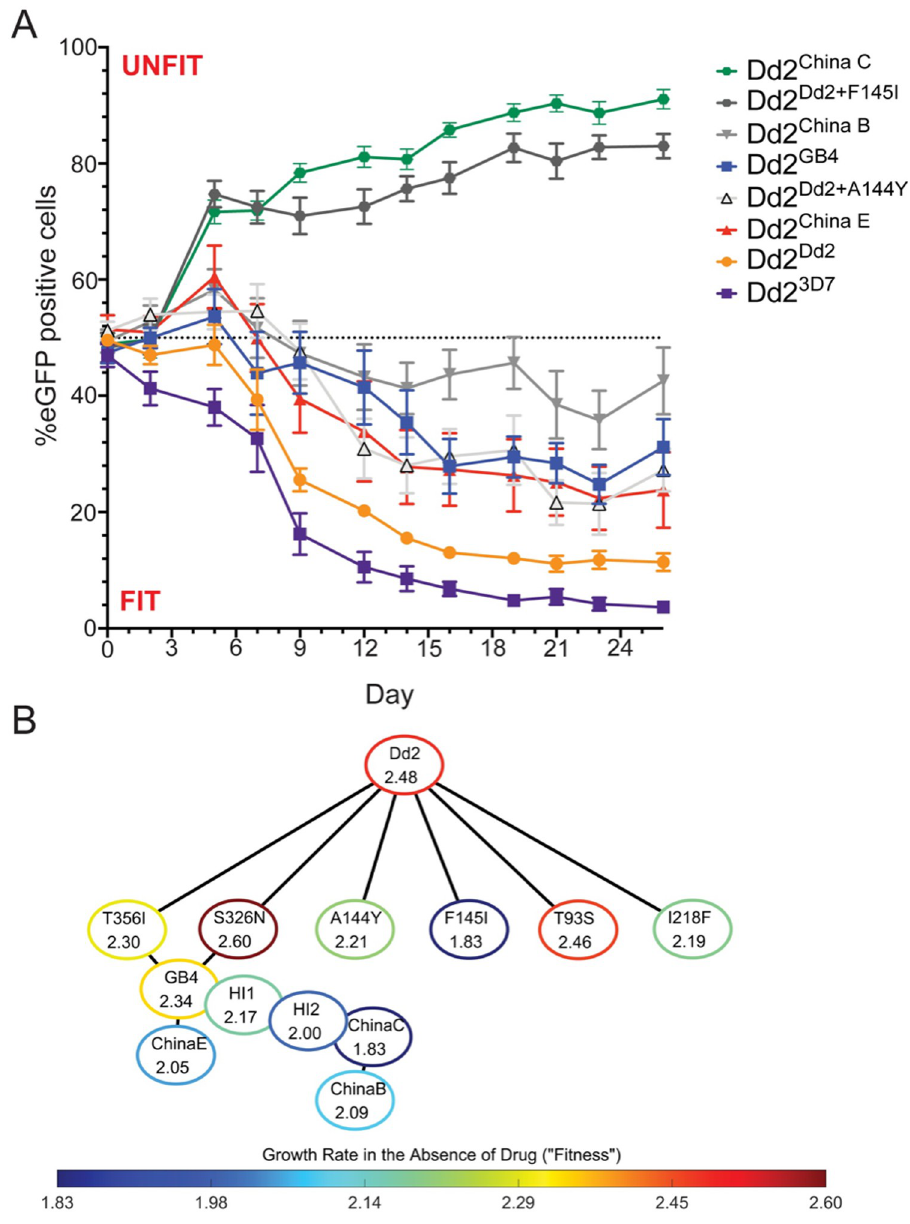
Fig 4. PfCRT mutations reduce parasite proliferation rates in vitro . ( A ) Edited pfcrt parasites were co-cultured with a GFP-expressing Dd2 line. Cultures were sampled every 2–3 days up to day 26 and were analyzed by flow cytometry. The mean ± SEM percentage of GFP + parasites was plotted over time. N , n = 4, 3. Values above the 50% dashed line indicate a line that was less fit than the GFP + parasites. Dd2 China C and Dd2 Dd2+F145I were significantly less fit than the Dd2 GFP reporter line. ( B ) Visualization of the fitness landscape of the parasite lines in the absence of drug. Each node demonstrates the pfcrt allele being expressed in an isogenic Dd2 parasite line and its absolute 24-hr growth rate; nodes are outlined in colors that indicate these growth rates. Edges connect nodes that differ by only a single PfCRT amino acid. Two hypothetical intermediate nodes (HI1 and HI2) were linearly interpolated to make the landscape fully connected, by creating a bridge between GB4 and China C, which differ by 3 amino acid